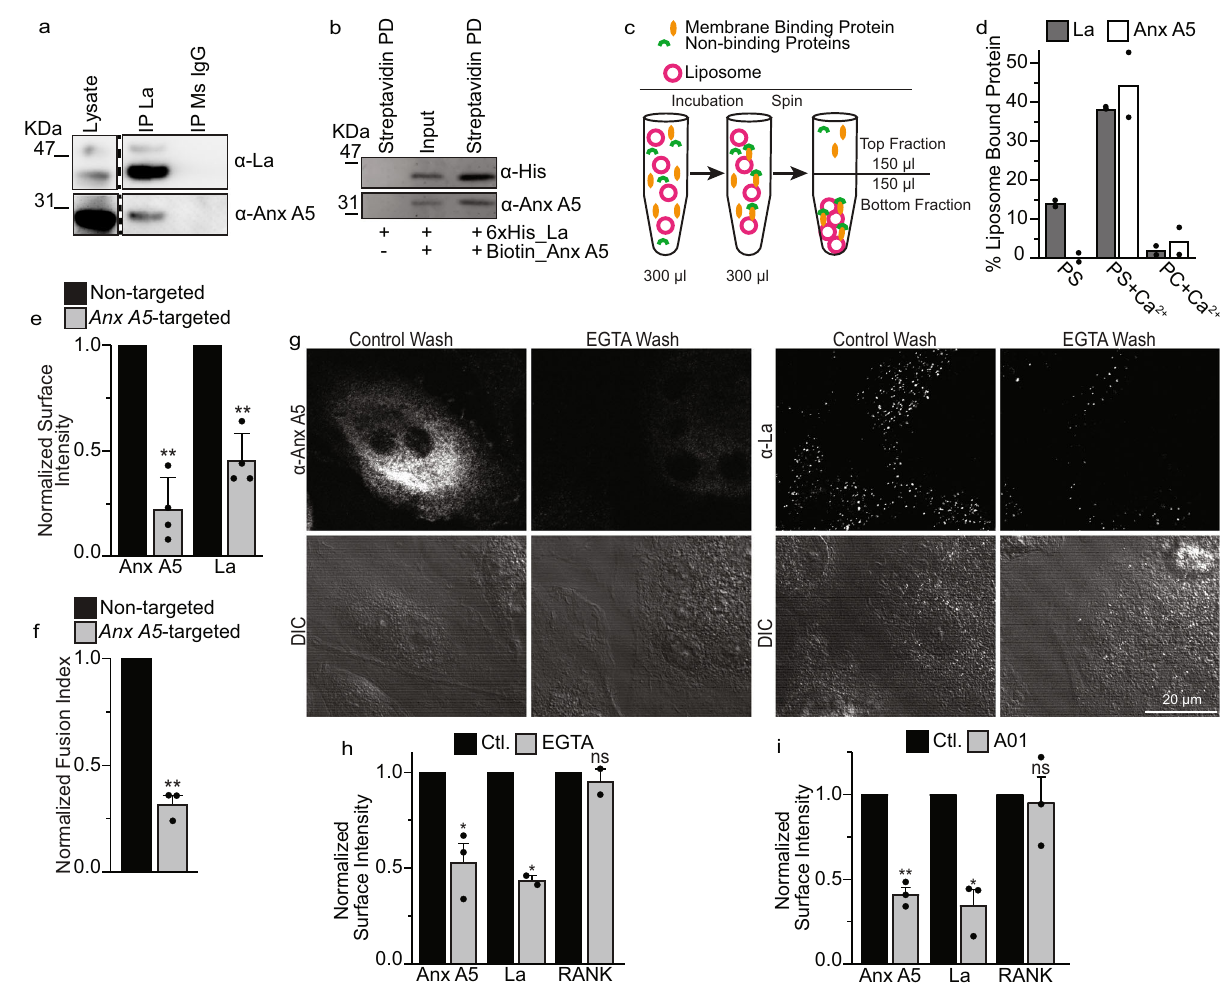
Fig. 5 | La associates with the surface ofosteoclasts bydirect interactions with Anx A5. a Immunoprecipitation of osteoclast lysates 3 days post-RANKL addition. La supermolecular complexes were captured on immunomagnetic beads via α -La mAb or isotype control and complexes were blotted with rabbit antibodies raised towards the targets of interest ( α -La rAb for La). Lanes from the same blot are presented atthe same intensity. Lanes of interest were cropped and placed beside oneanother,dividedbyadashedline. (b) RepresentativeWesternblotofmagnetic, streptavidinpull-downofBiotin-AnxA5.Lane2=La+AnxA5inputbeforepull-down and Lane 1 = La alone and Lane 3 = La+Anx A5 after pull-down. c A cartoon illus- tration of our approach to identify membrane af fi nity by comparing protein con- tents in the Bottom fraction containing, along with soluble proteins, liposome- boundproteinsandintheTopfractioncontainingsolubleproteinsanddepletedof liposome-bound proteins. (d) Quanti fi cation of the enrichment of recombinant La and Anx A5 in the bottom fraction containing pelleted liposomes (n=2).